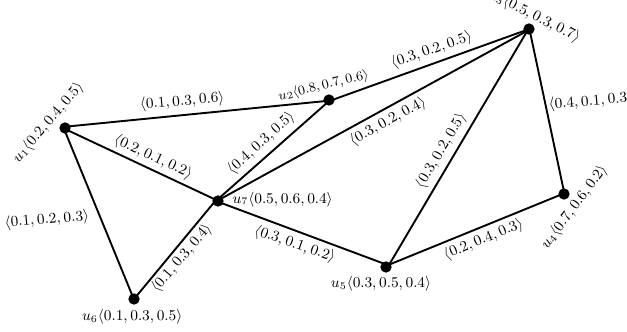
Figure 3: Single-valued neutrosophic graph. Figure 3. Single-valued neutrosophic